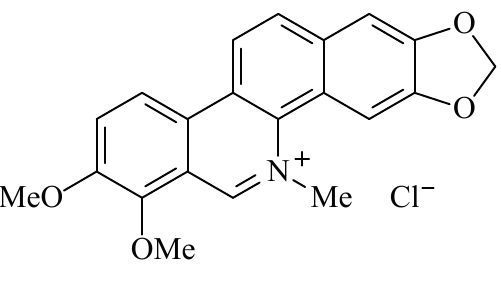
Figure 6. Chelerythrine